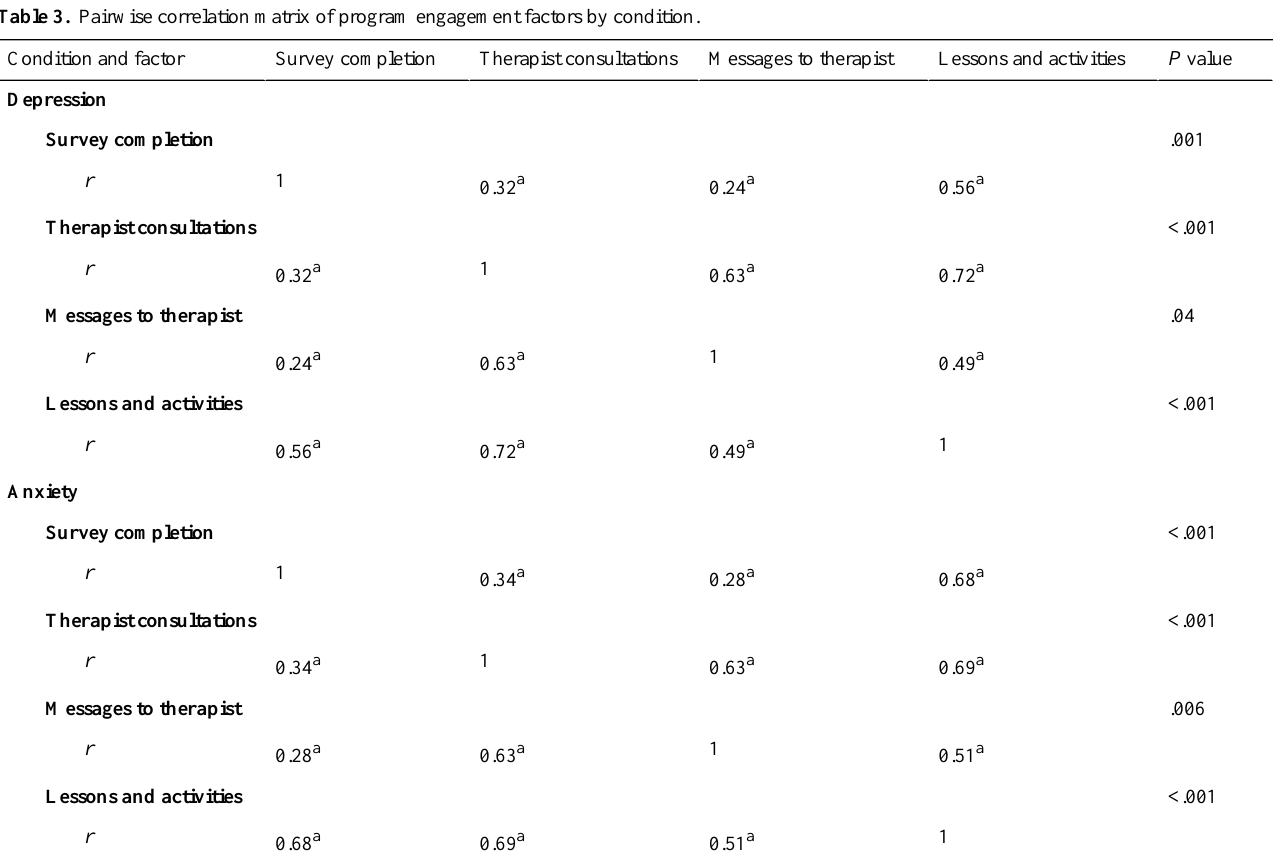
Table 3. Pairwise correlation matrix of program engagement factors by condition.